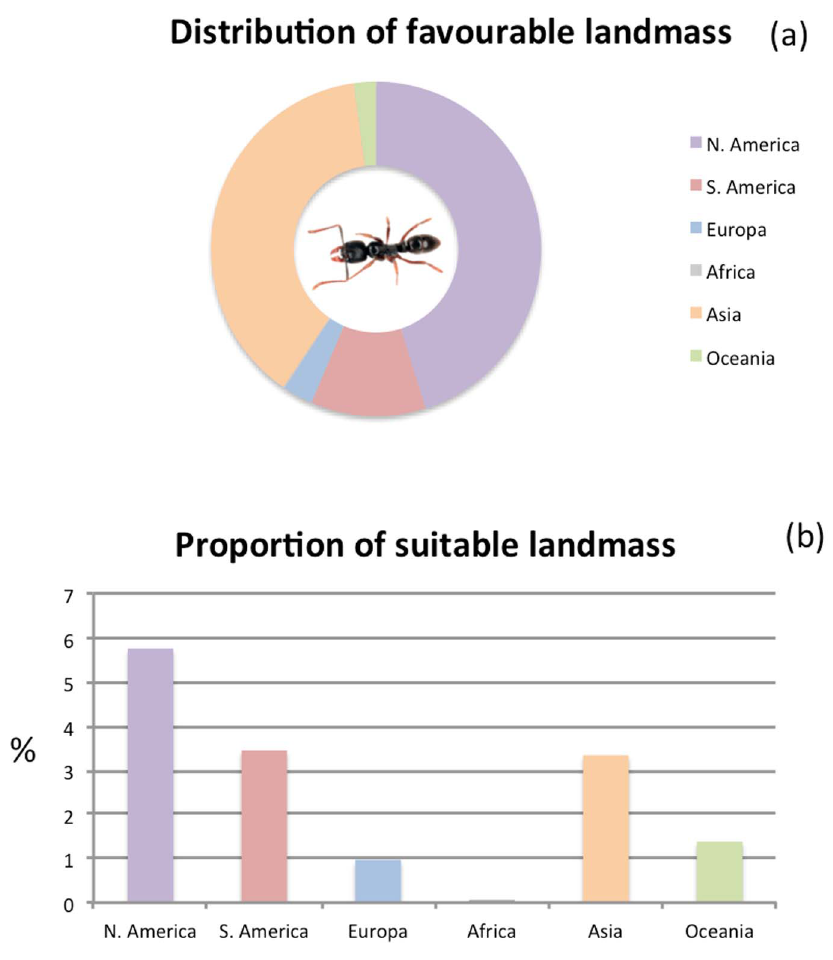
Figure 2. a + b Distribution and proportion of suitable landmass under current climatic conditions among six biogeographic regions.